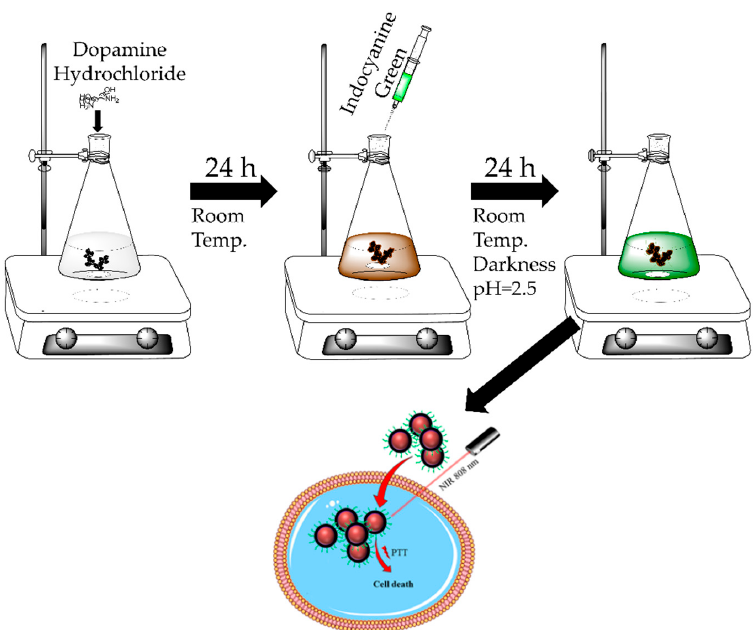
Figure 1. Schematic of the synthesis of polydopamine (PDA)-coated nanodiamonds (NDs) with indocyanine green (ICG) conjugation, and its application in the photothermal therapy (PTT) of the glioblastoma cell.